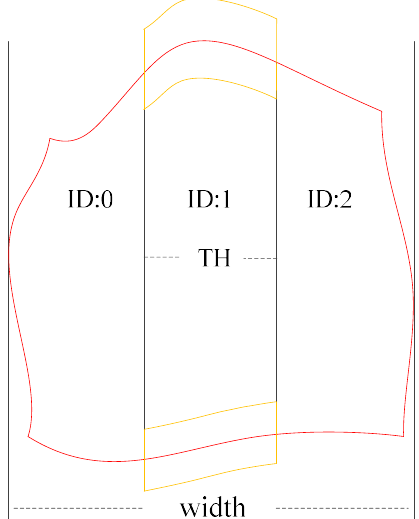
Figure 4. Geometrical deformation process. The red frame is the extracted block, which is divided into three sub-blocks. The yellow frames are the end-blocks of the middle sub-block. TH is a given value.